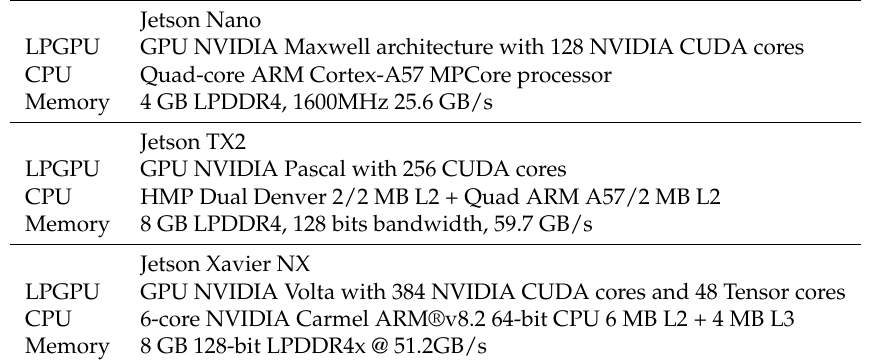
Table 8. Most relevant characteristics of the NVIDIA modules Jetson Nano, Jetson TX2 and Jetson Xavier